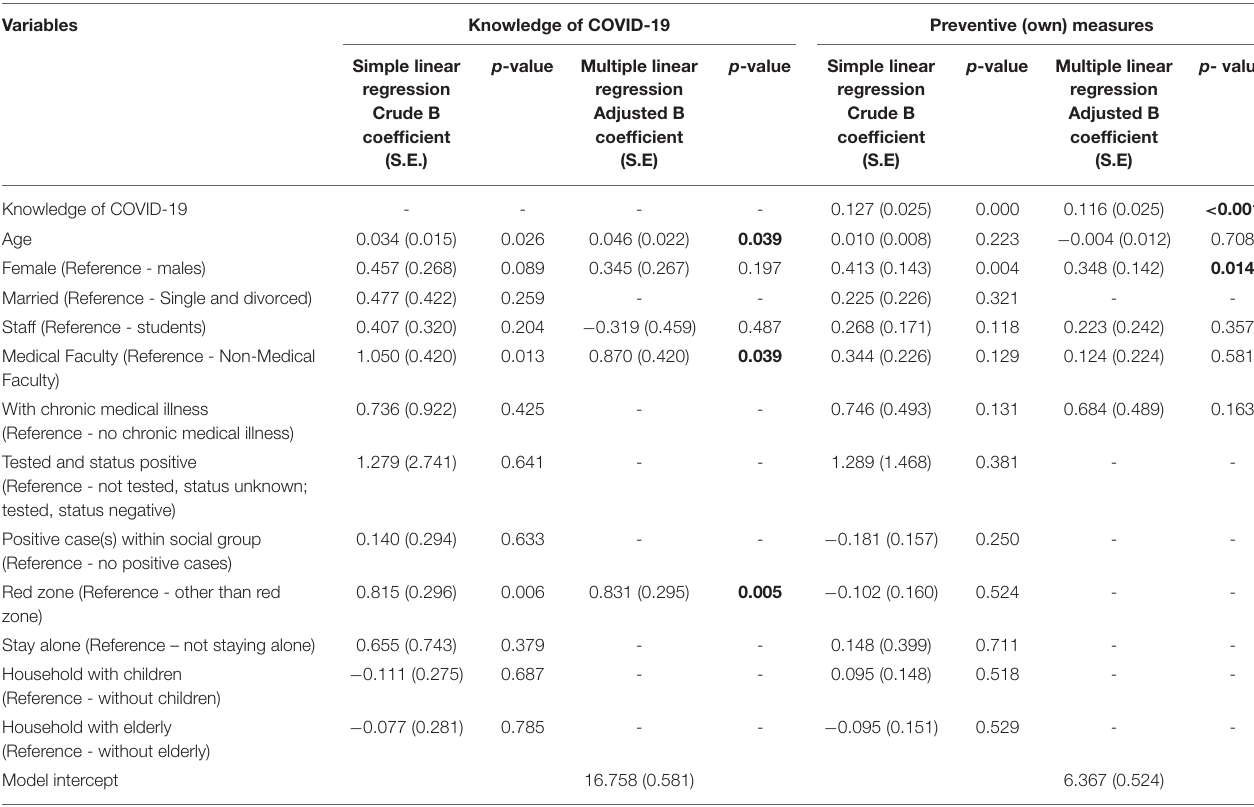
TABLE 7 | Factors associated with knowledge and preventive (own) measures toward COVID-19 in respondents ( n =